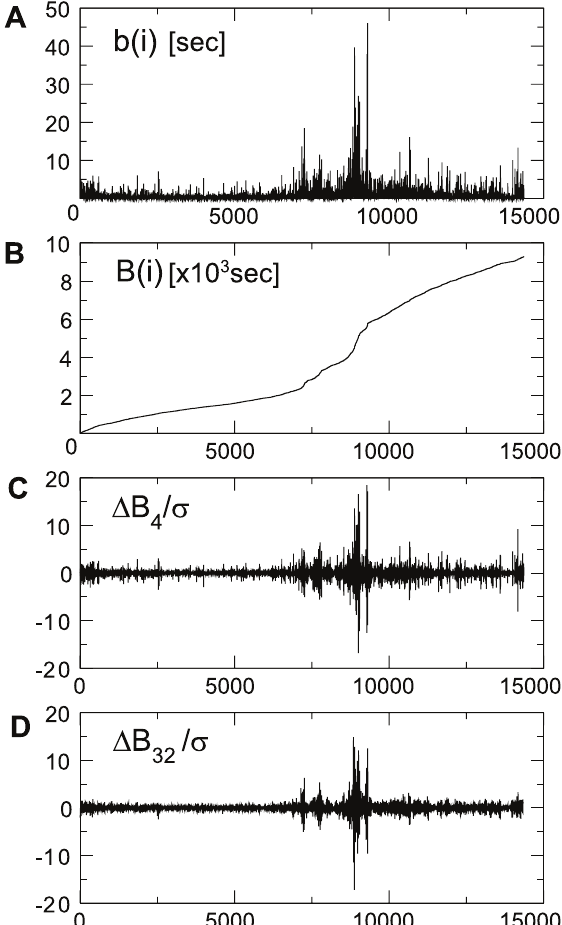
Figure 1. Illustration of the method to extract the non- Gaussianity in the ISI fluctuations. (A) ISI’s of a spike train of a neuron are displayed chronologically. (B) Cumulated ISI’s. (C)(D) ISI fluctuations were calculated by detrending (defined in the text) at s ~ 4 (C) and s ~ 32 (D). The spike train was taken from a cortical neuron # 12 when the animal was awake.